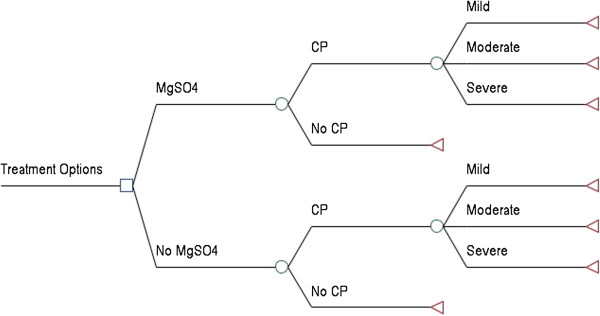
Decision tree for the imminent preterm birth models. The decision tree used to compare standard care (no treatment) with administration of magnesium sulphate to patients in whom preterm birth at < 32+0 weeks gestation is imminent.